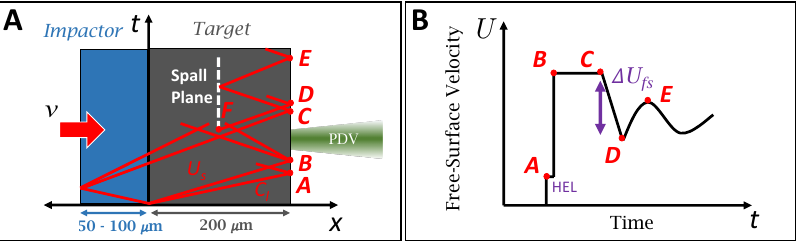
Figure 3. The spall failure process via plate impact. ( A ) A Lagrangian time vs. position diagram over the plate impact event depicting the propagation of waves leading to spall failure. ( B ) An idealized velocity vs. time trace gleaned from velocimetry measurements of the target’s free-surface. The points on the curve follow those specified in ( A